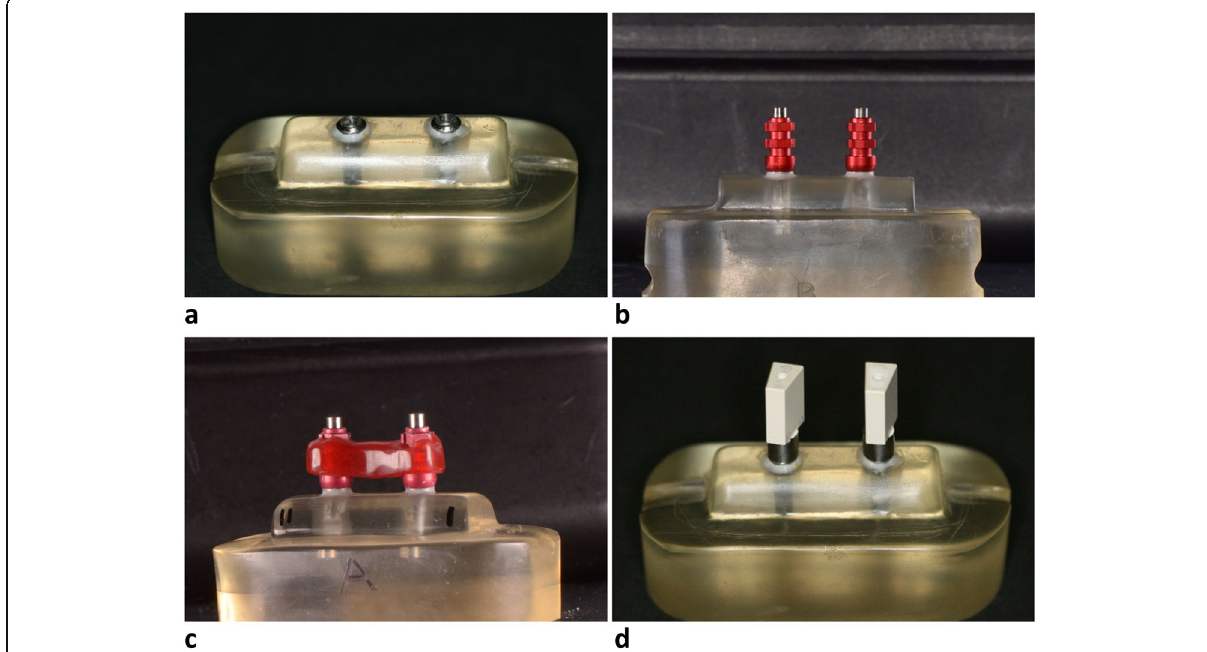
Fig. 1 One of the master models. a A master model with a simulated healed ridge and 2 parallel implants. b The master model with separate impression copings for the NSP impression technique. c The impression copings were splinted for the SP impression technique. d The model with the scan bodies attached to the implants prior to